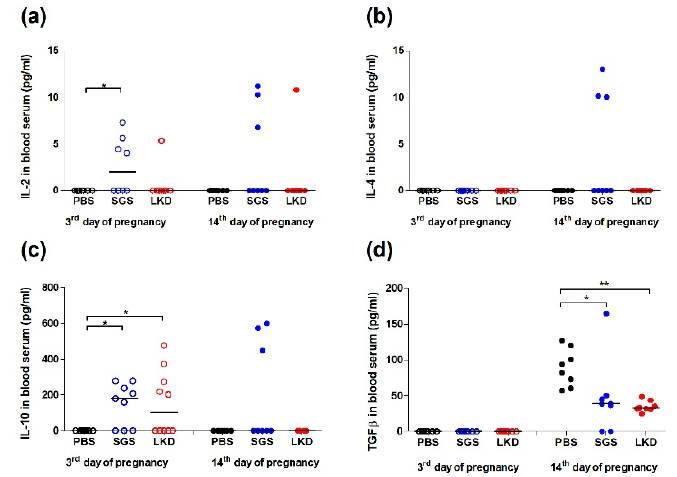
Figure 2. Effect of SGS and LKD on the levels of ( a ) IL-2, ( b ) IL-4, ( c ) IL-10, and ( d ) TGF β 1 at 3 dpc and 14 dpc in abortion-prone mice. Data were analyzed using one-way analysis of variance (for normally distributed data), followed by Bonferroni’s multiple comparison post hoc test or the Kruskal–Wallis test (for non-normally distributed data), followed by Dunn’s multiple comparison post hoc test ( p < 0.05). Data are presented as individual values with the median. * p < 0.05 and ** p < 0.01.